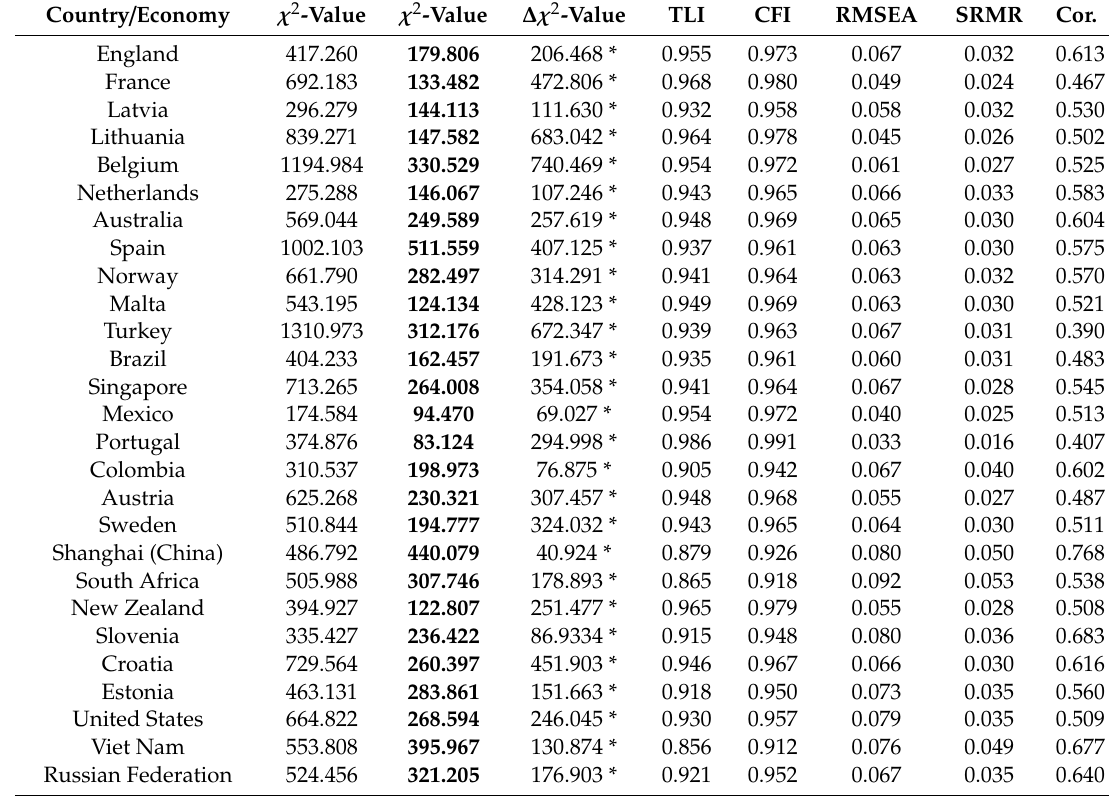
Table 4 for all the 27 selected countries or economies. The chi-square degree of freedom dropped to 17 as a result of the inclusion of one item cross-loading. The chi-square values from Table 3 are included in Table 4 for natural juxtaposition with the new chi-square values (in bold faces), and the respective changes in chi-square values between individual country or economy after using Satorra (cid:21) Bentler corrections are presented. Table 4. Selected GOF indices for the second measurement models of the TALIS 2018 teacher job satisfaction